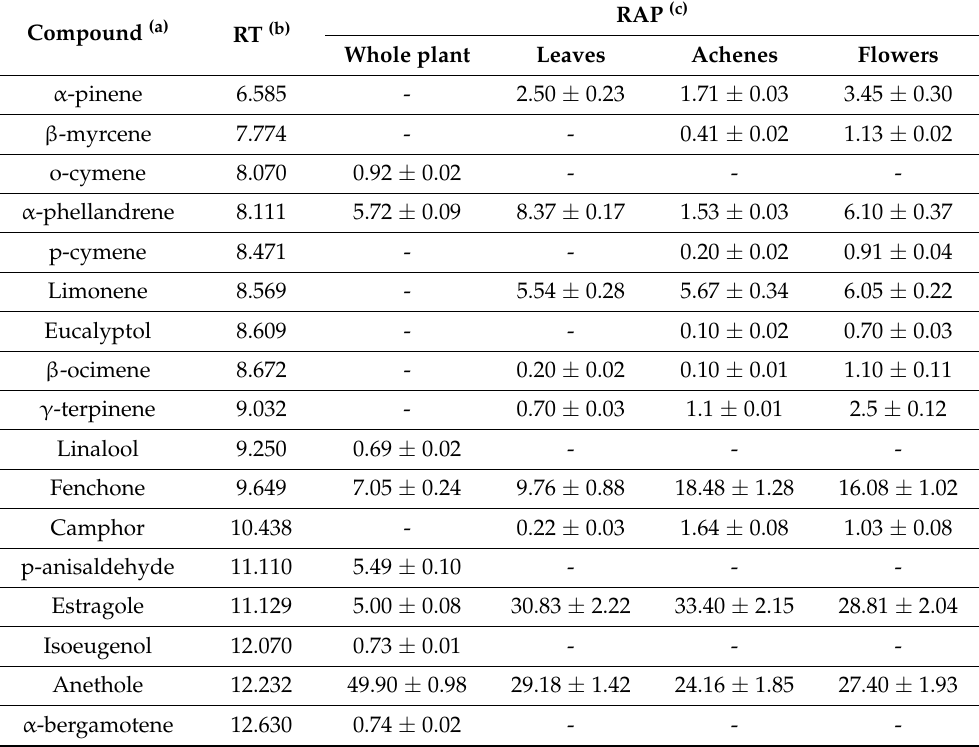
Table 1. Phytochemical profiles of Foeniculum vulgare subsp. piperitum essential oils.